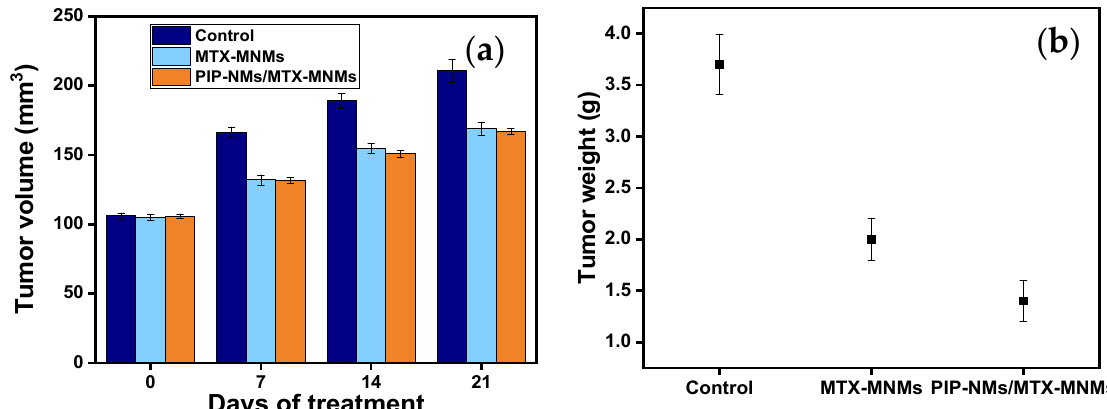
Figure 8. ( a ) Tumor volume (mm 3 ) and ( b ) tumor weight of mice treated with distilled water as a control group, MTX-MNMs and PIP-NMs/MTX-MNMs combination. Data represented as mean ± SD ( n = 7).